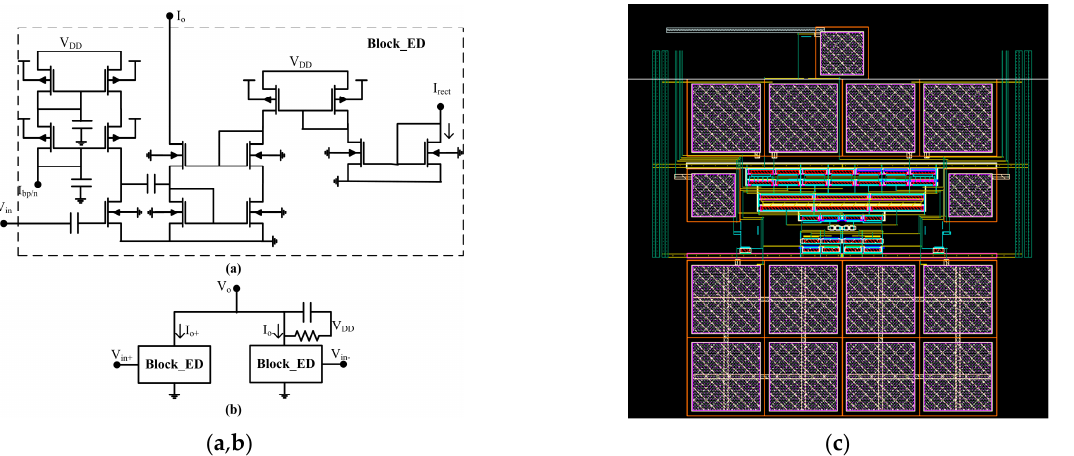
Figure 15. ( a ) Single-ended core of the envelope-detector block. ( b ) Whole ED. ( c ) ED layout.